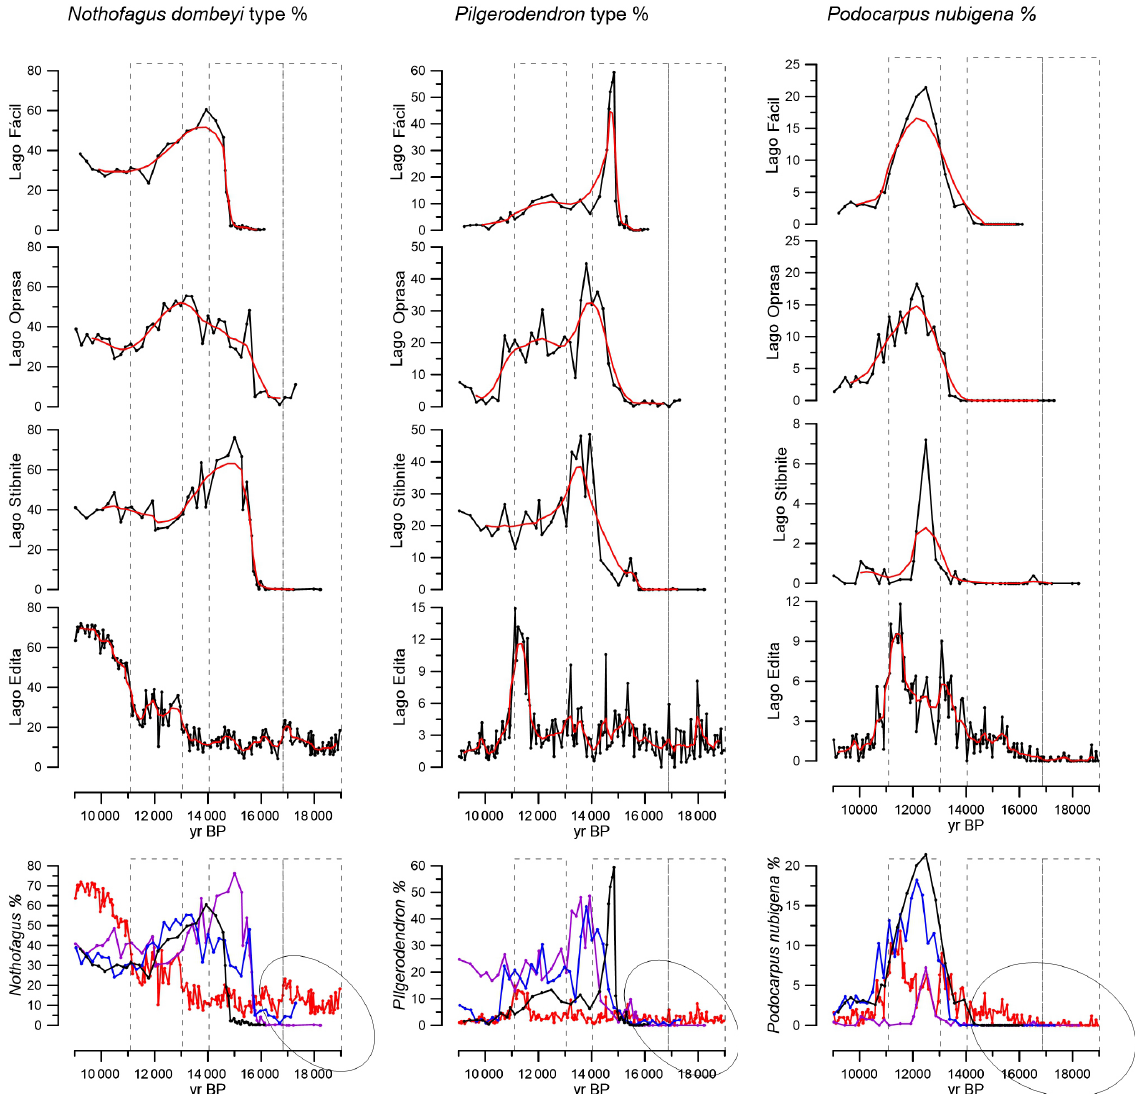
Figure 7. Comparison of selected tree pollen recorded in Lago Fácil, Lago Oprasa, Lago Stibnite (Lumley and Switsur, 1993) and Lago Edita. The red line corresponds to a weighted running mean in each record of seven adjacent samples with a triangular filter. The lower panels show the curves from all sites expressed in a common percent scale (Lago Fácil is the purple line, Lago Oprasa is the blue line, Lago Stibnite is the black line and Lago Edita is the red